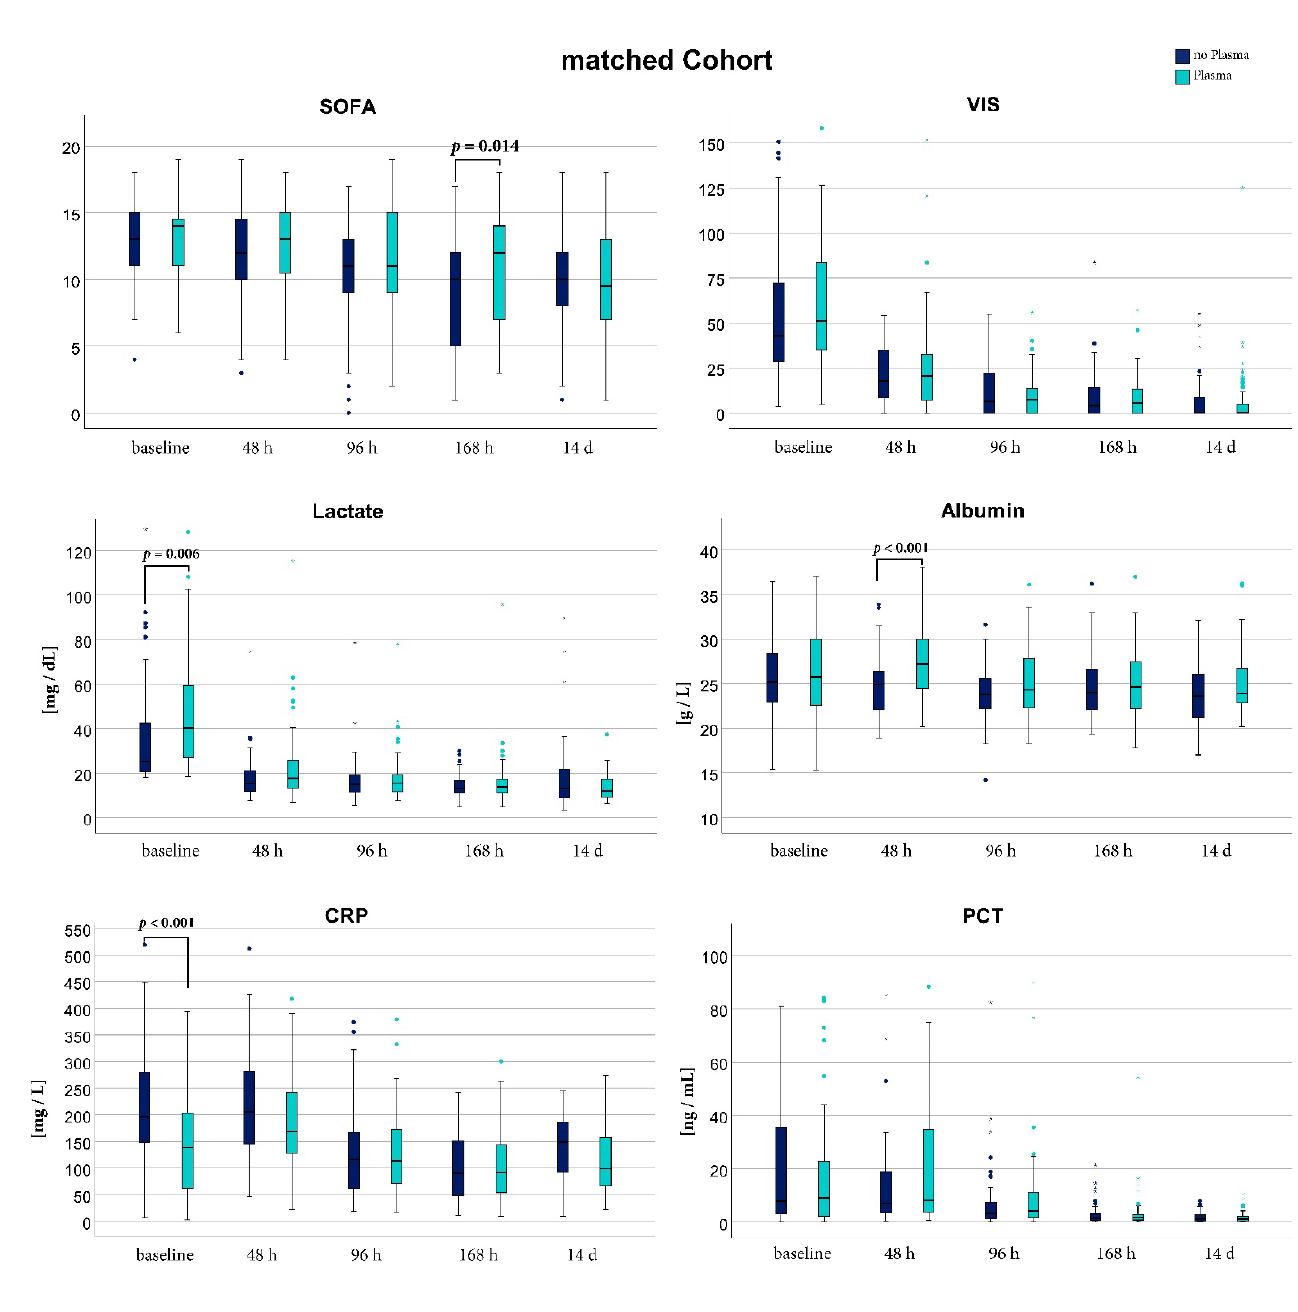
Figure 5. Septic shock related parameters at different points in time of the matched cohort. Comparison of the plasma group (cyan) and the control group (dark blue) was performed with a Mann Whitney U test. SOFA: Sepsis related Organ Failure Assessment Score; VIS: Vasoactive Inotropic Score; CRP: C-related Protein; PCT: Procalcitonin; [mg/dL]: milligram per deciliter; [g/L] gram per liter; [mg/L]: milligram per liter; [ng/mL]: nanogram per milliliter.